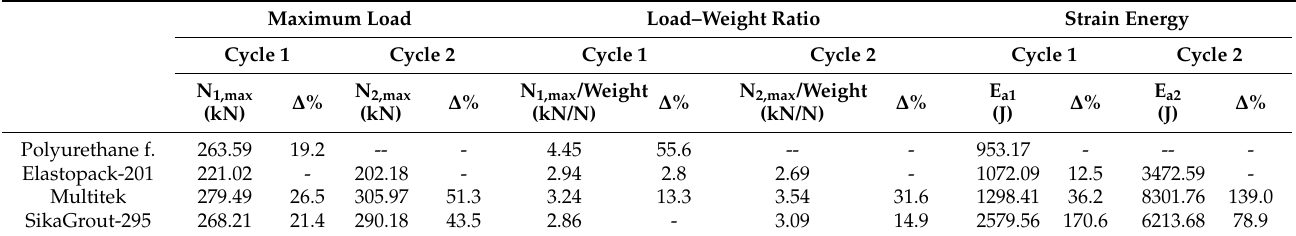
Table 6. Percentage difference in maximum load, the load–weight ratio of the tubes and the strain energy during the test. Maximum Load Load–Weight Ratio Strain Energy Cycle 1 Cycle 2 Cycle 1 Cycle 2 Cycle